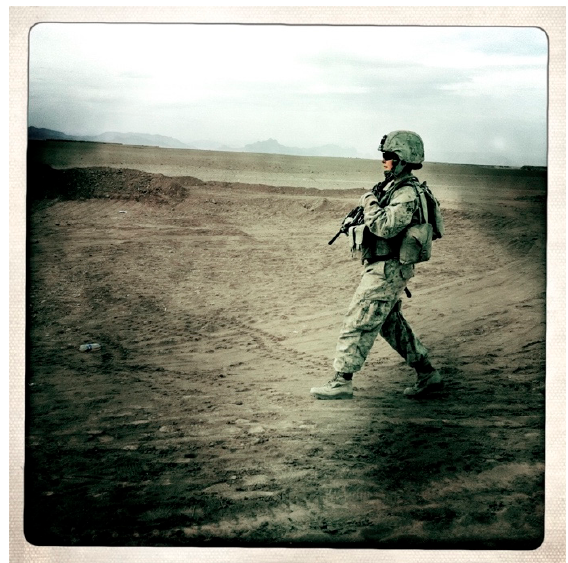
Figure 2. Body armour. Source: created by Rita Leistner (used with photographer’s permission).